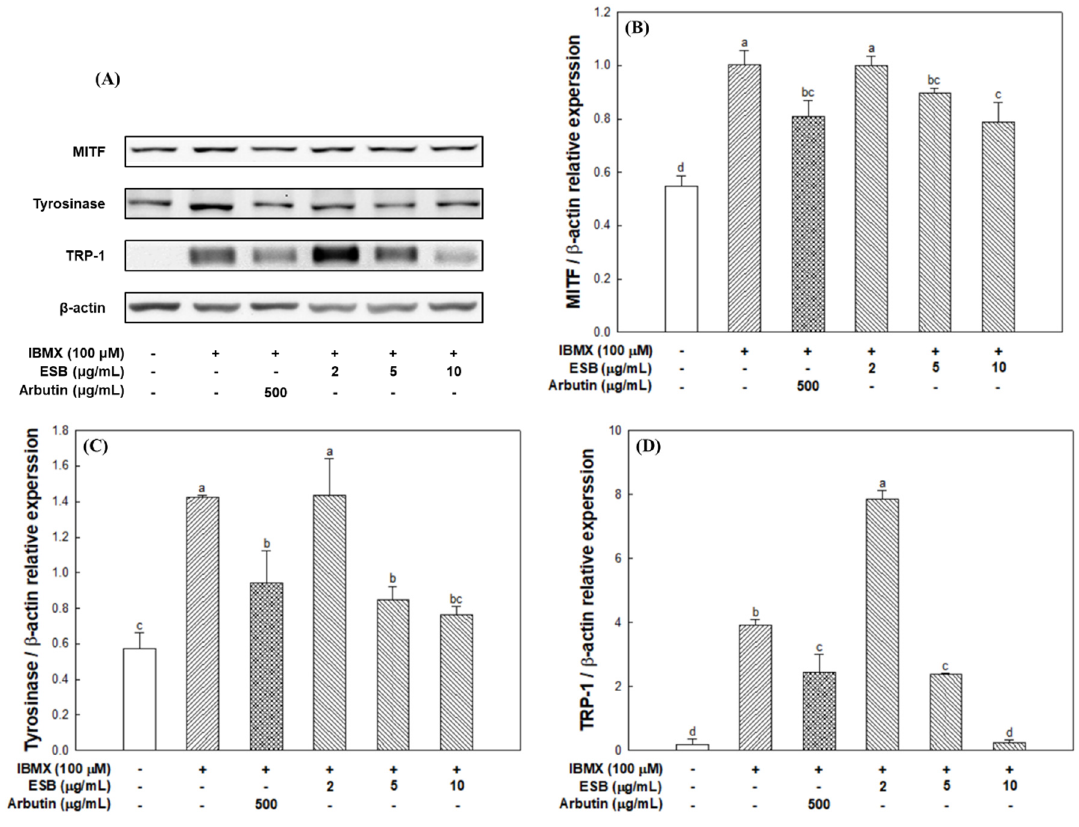
Figure 5. Anti-melanogenic effect of the 60% ethanolic extract of Sorghum bicolor (ESB) on